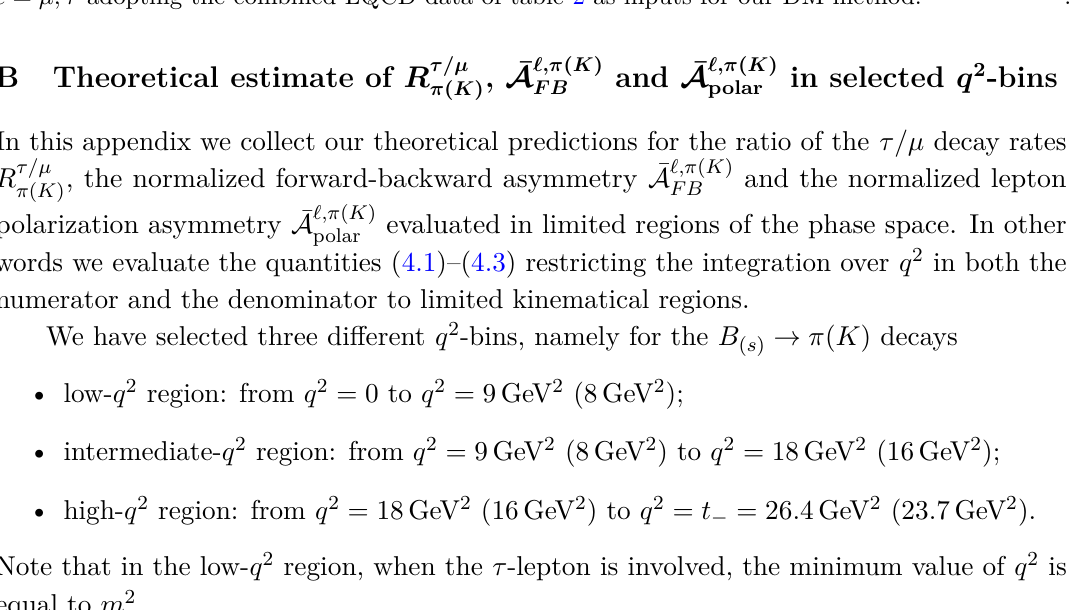
Table 9 . The same as in table 8, but in the case of the semileptonic B s → K‘ν ‘ decays with ‘ = µ, τ adopting the combined LQCD data of table 2 as inputs for our DM